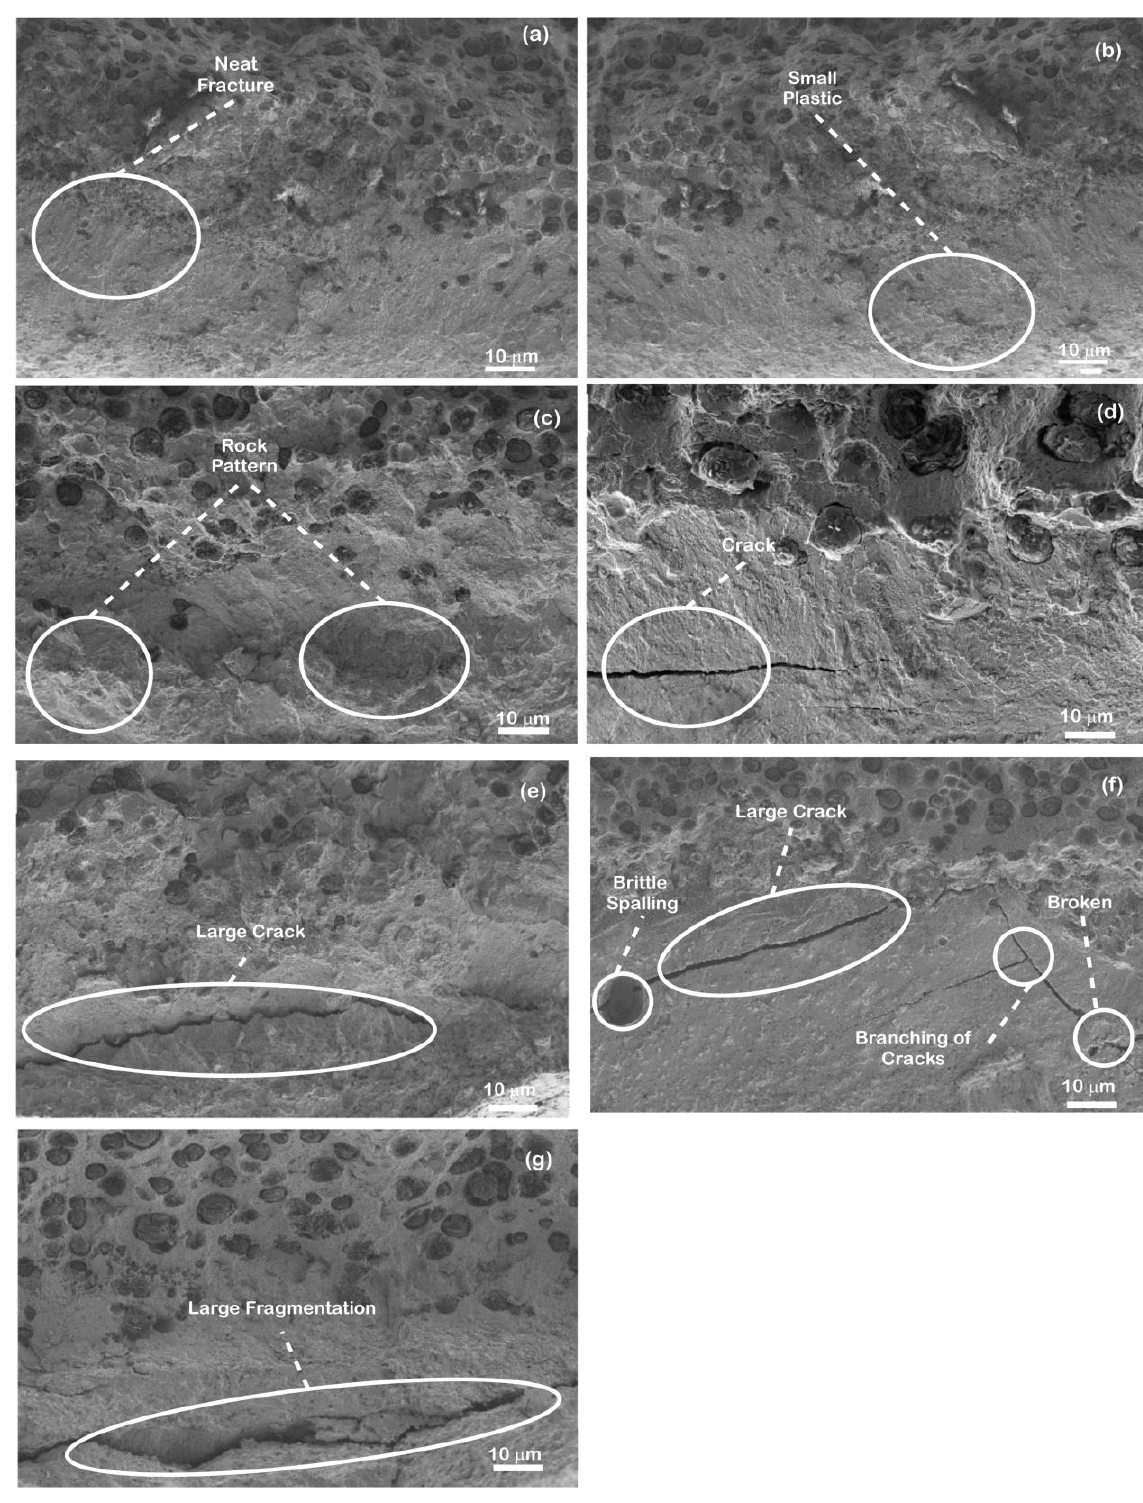
Figure 14. Fracture structure of bonding among matrix and coating below 500 × ; ( a ) 10% B 4 C, ( b